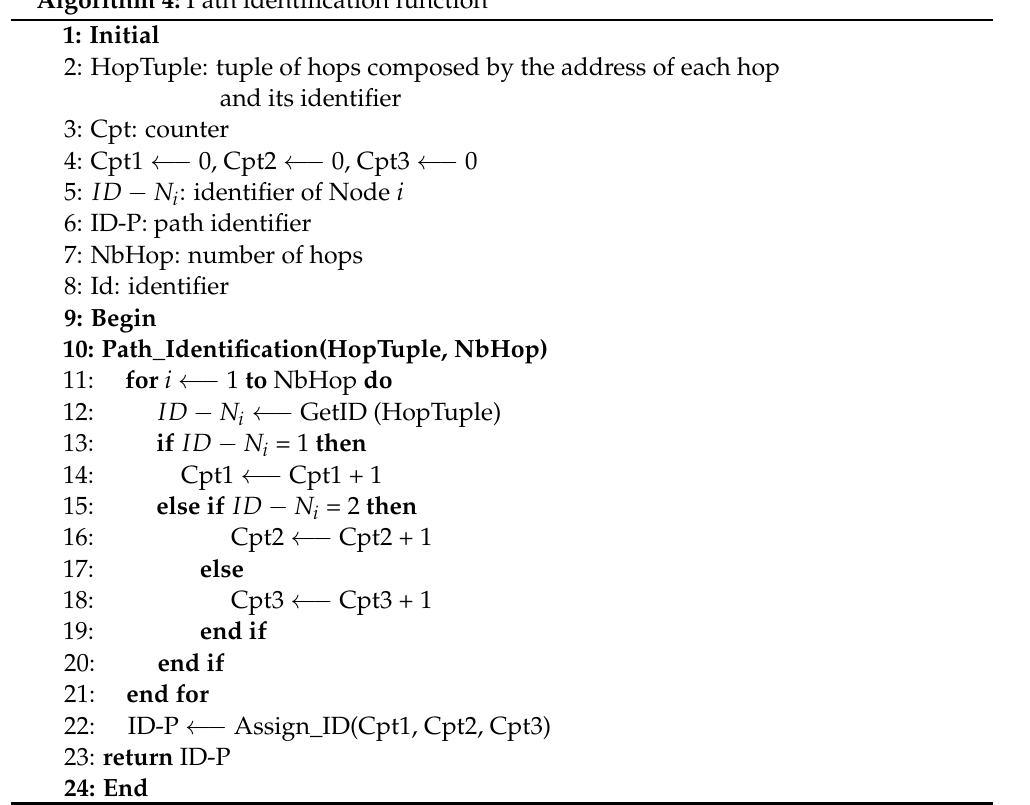
Algorithm 4: Path identification function